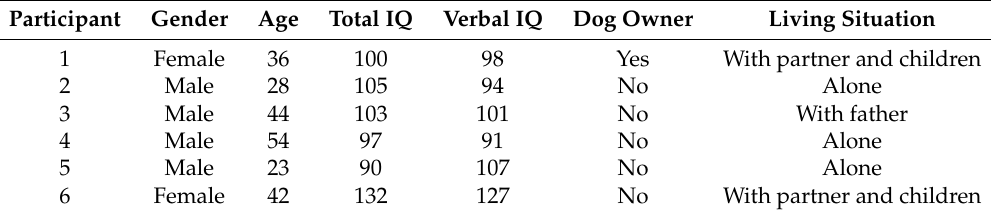
Table 1. Baseline